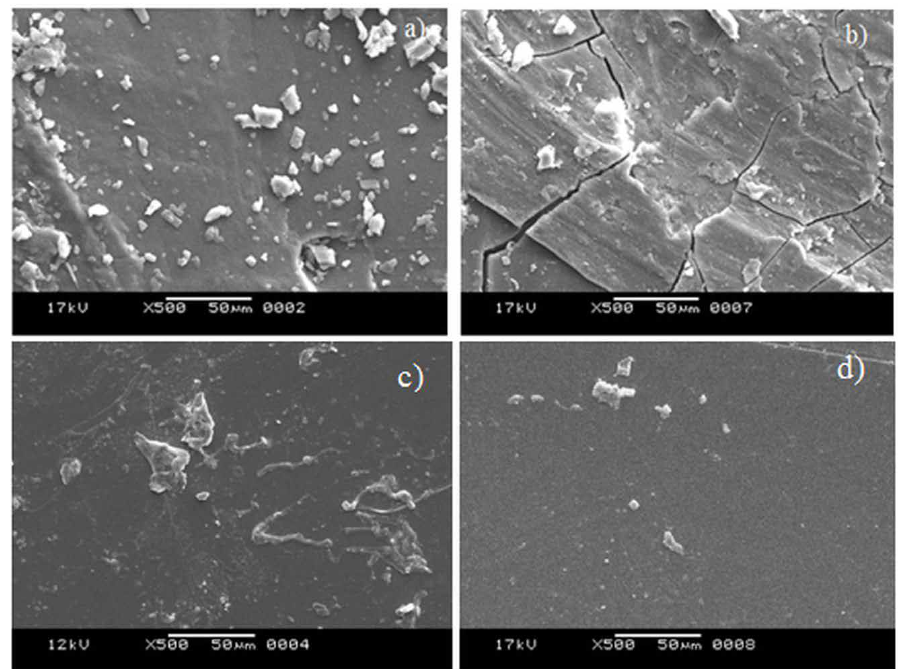
FIGURE 7 – Scanning electron micrographs of PVP K30-Met base PM (a), PVP K30-Met base 5:1 SD (a), Pure drug (Met base) loaded patch (c) and SD loaded patch